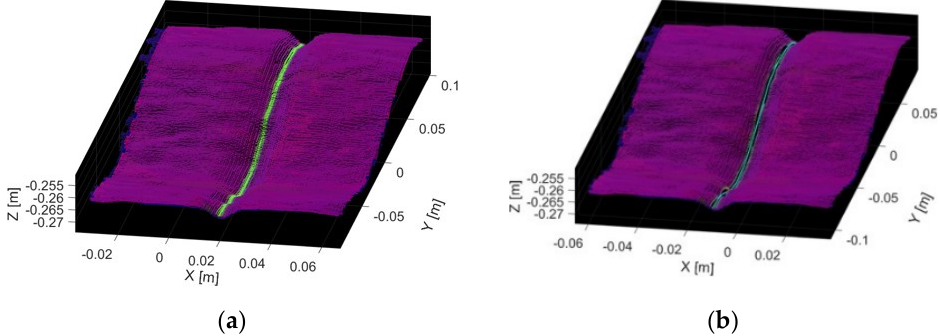
Figure 8. V-type butt joint trajectory extraction: ( a ) point cloud with HSV data; ( b ) surface with the computed path.